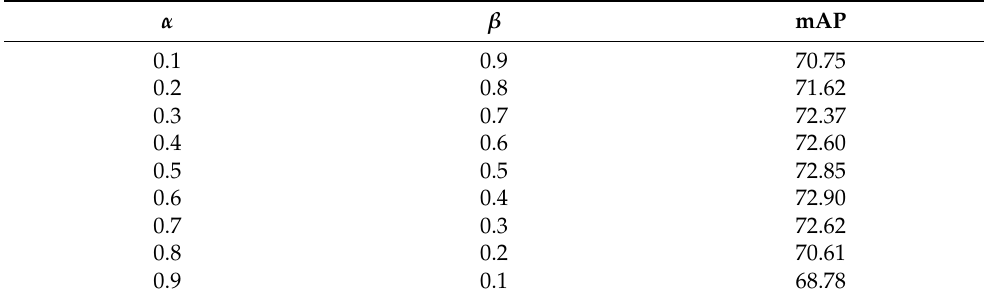
Table 11. The influence of α and β on retrieval. The maximum mAP value is bolded.